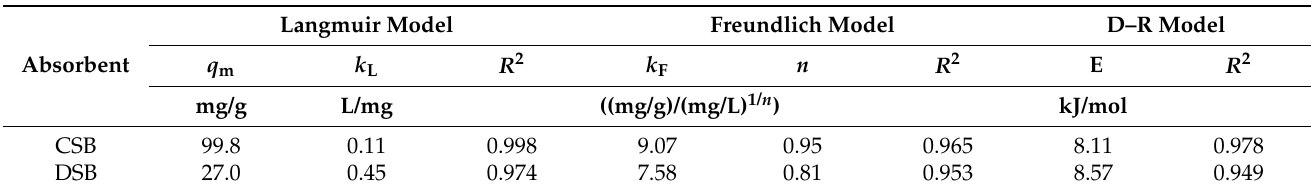
Figure 3. ( a ) Isotherms of 17 β -estradiol (E2) adsorption onto corn straw and dewatered sludge biochars (CSB and DSB). The solid line represents the Langmuir model, and the dotted line represents the Freundlich model; ( b ) D-R isotherm plots for the E2 adsorption on CSB and DSB. Table 3. The adsorption isotherm parameters of 17 β -estradiol (E2) by corn straw and dewatered sludge biochars (CSB and